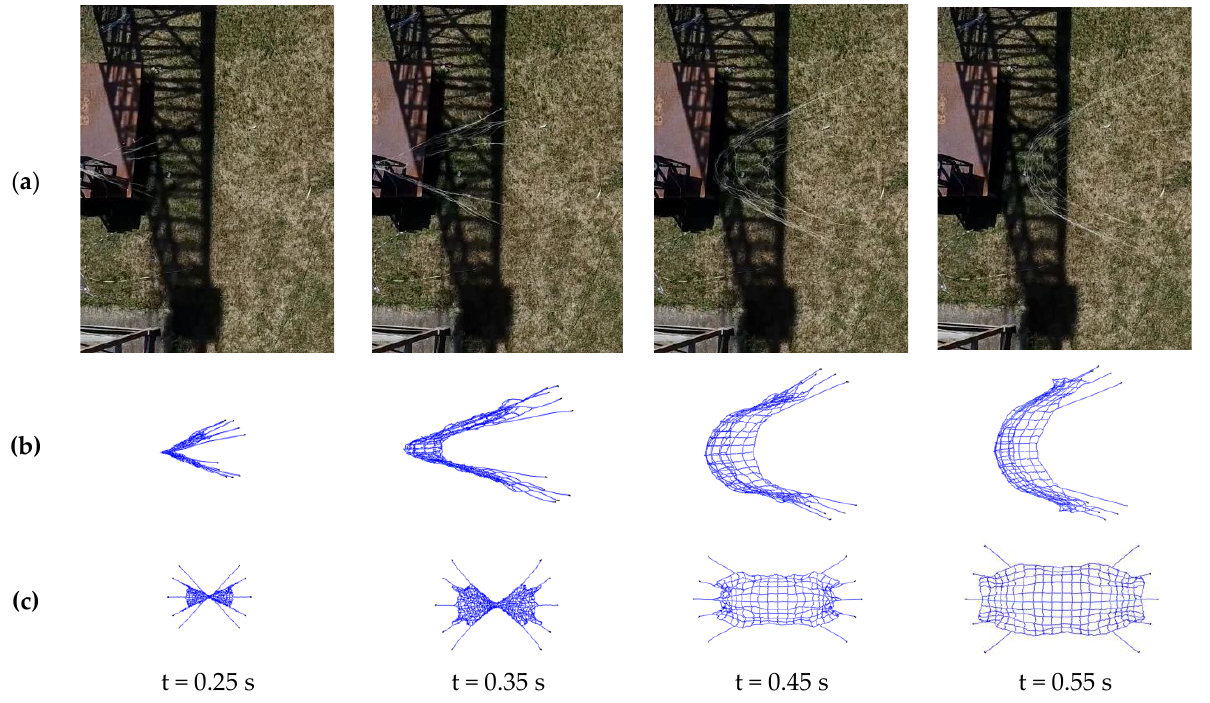
Figure 12. Comparison of tether-net configuration between simulations and experiments. ( a ) On-site photos of on-ground experiments. ( b ) Main view of simulation results. ( c ) Top view of simulation results.